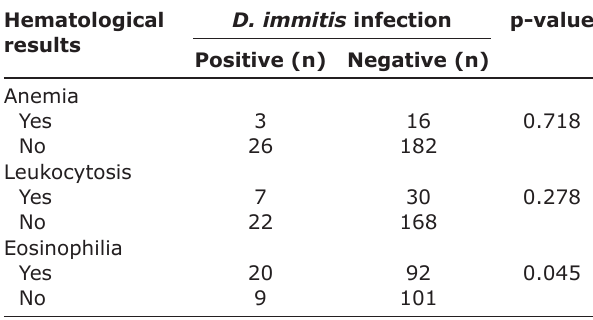
Table-4: Association of hematological parameters and D. immitis infection in pet and semi-domesticated cats. Hematological results